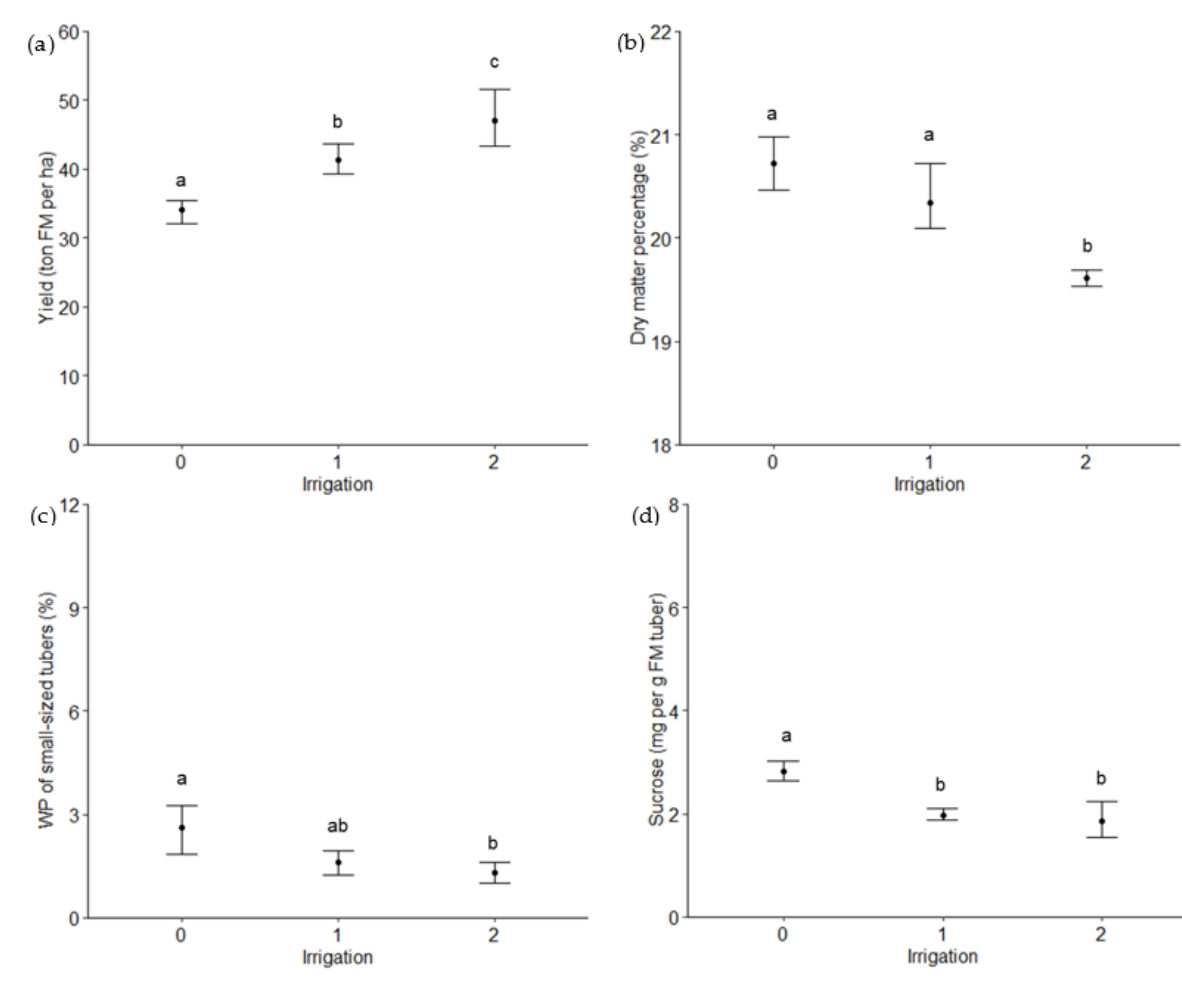
Figure 3. The effect of irrigation on ( a ) potato fresh matter (FM) yield, ( b ) dry matter content of tubers (DM%), ( c ) weight percentage (WP%) of small tubers (<60 mm), and ( d ) sucrose content of FM tubers in the 2018 irrigation experiment. The three irrigation treatments were: (0) no-irrigation, (1) maintain soil moisture content at 60% field capacity (60% FC) and (2) maintain soil moisture content at 80% field capacity (80% FC). The point indicates the mean of the observed values, and an error bar indicates the 95% confidence interval of the means. No overlap of letters between treatments refers to a statistically significant difference ( p < 0.05).